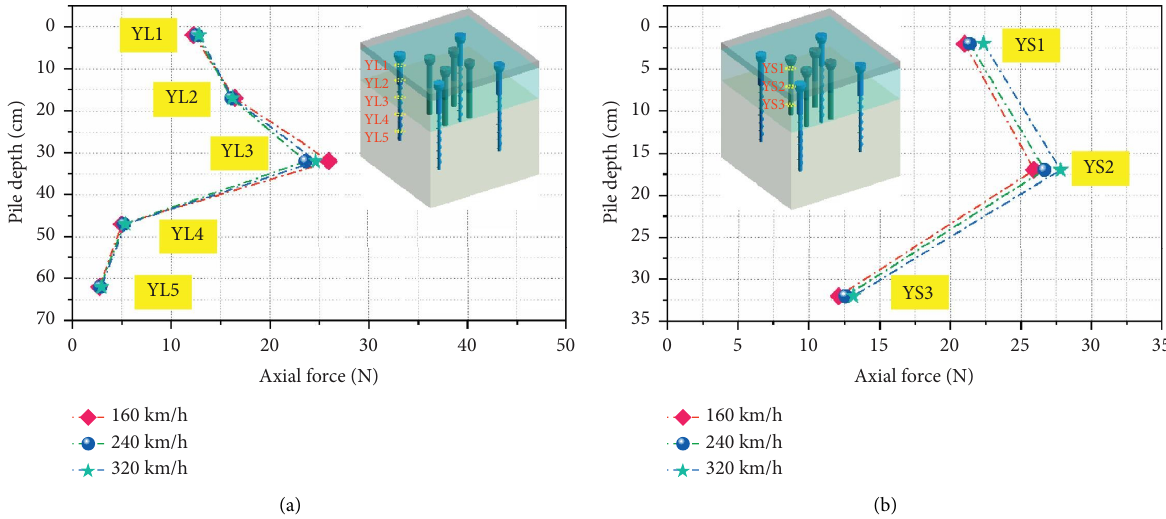
Figure 10: Te peak distribution curve of the axial force. (a) Distribution of peak axial force of the long pile. (b) Distribution of peak axial force of the short pile.